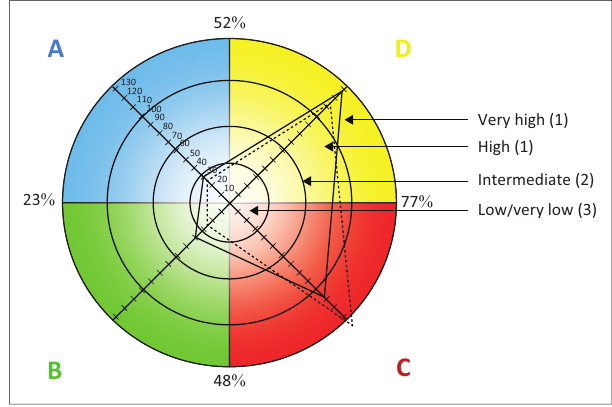
FIGURE 3: Determining thinking preferences. 38